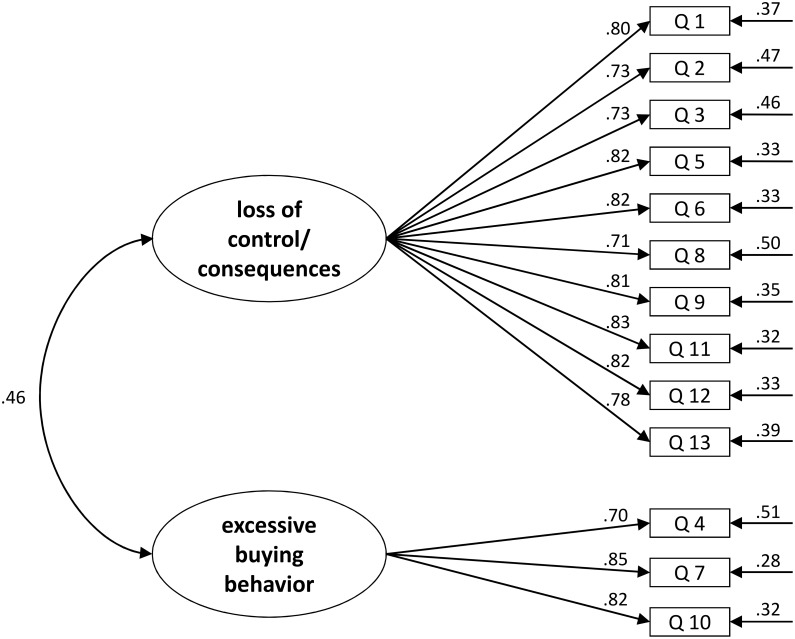
Results of the confirmatory factor analysis, study 2 (n = 1,905).RMSEA = 0.08, CFI = 0.96, TLI = 0.95, and SRMR = 0.04.